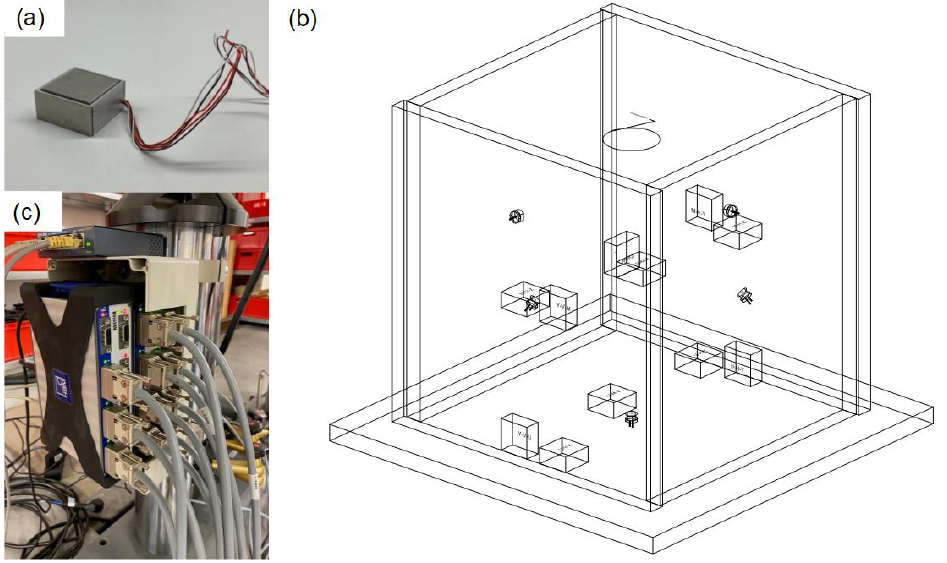
Figure 3. ( a ) Pressure measurement cell, ( b ) 3D model of the test box with sensor locations, ( c ) QuantumX DAQ system.